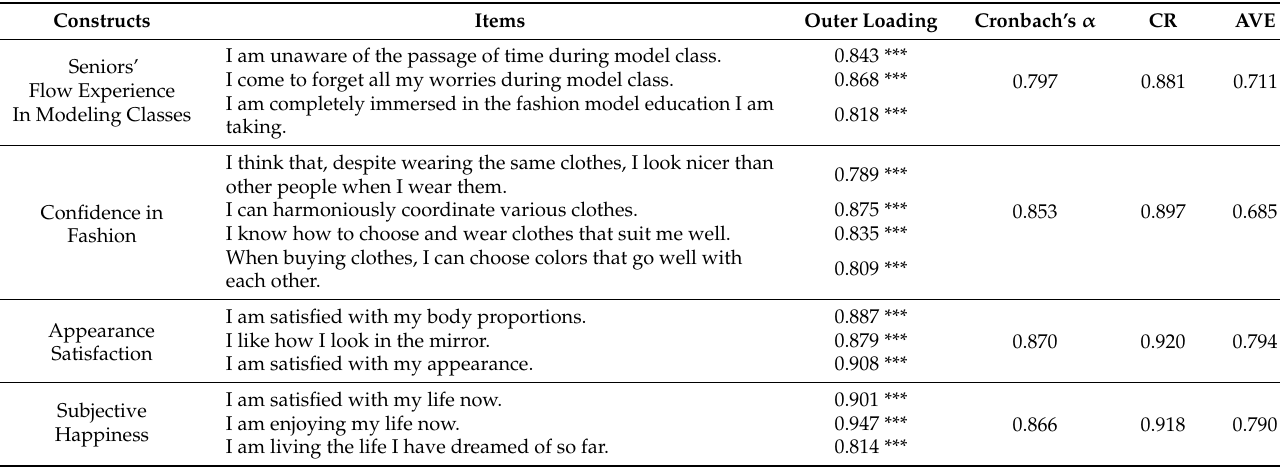
Table 1. Results of reliability and confirmatory factor analysis.